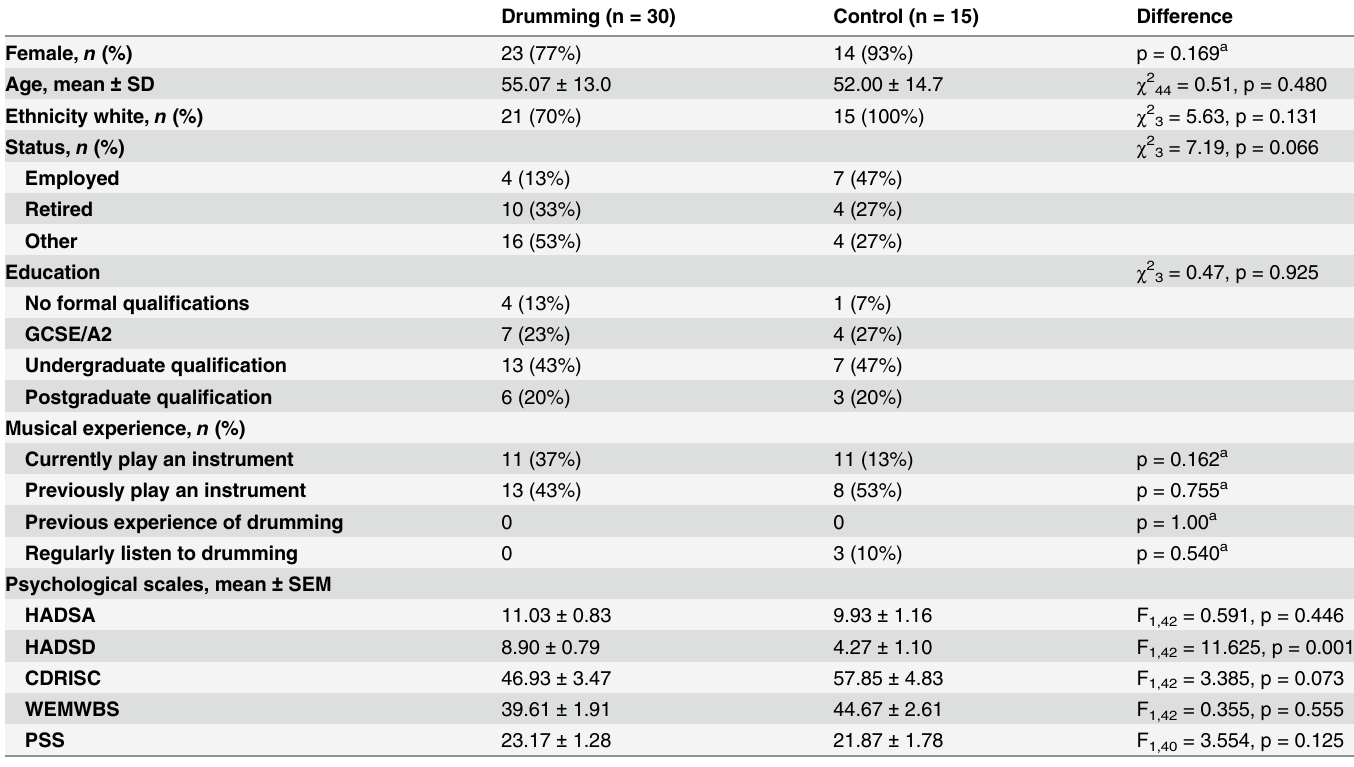
Table 1. Baseline